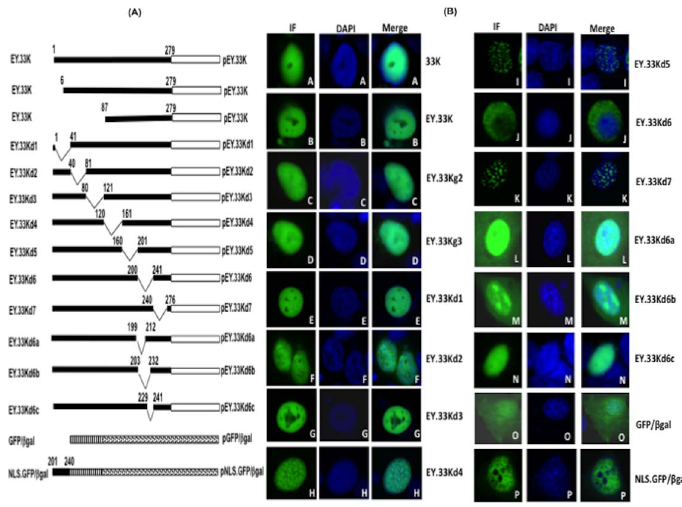
Figure 2. Sub cellular localization of 33K proteins. ( A ) Schematic representation of BAdV-3 33K fusion proteins . The number above the box denote the amino acid number for 33K protein. Thick box represent BAdV-3 DNA; hollow box represents EYFP DNA; stripped box represents GFP DNA; dotted box represents b -gal DNA. Thin lines represent deleted regions. The name of the individual mutant protein is indicated on the left of the panel. The name of the individual plasmid is indicated on the right of the panel. ( B ). Immunofluorescence . Monolayers of MDBK cells (panel A) infected with BAdV-3. At 24 hrs post infection, the cells were analysed by indirect immunofluorescence by staining with anti-33Kp serum, Cy 2 conjugated goat anti-rabbit serum and DAPI. Similarly, monolayers of HeLa cells (panels B to P) were transfected with individual plasmid DNA expressing indicated 33K fusion proteins and analysed at 48 hrs post transfection. Finally, the cells were stained with DAPI and analyzed by direct fluorescence. The name of the protein is indicated on the right of the